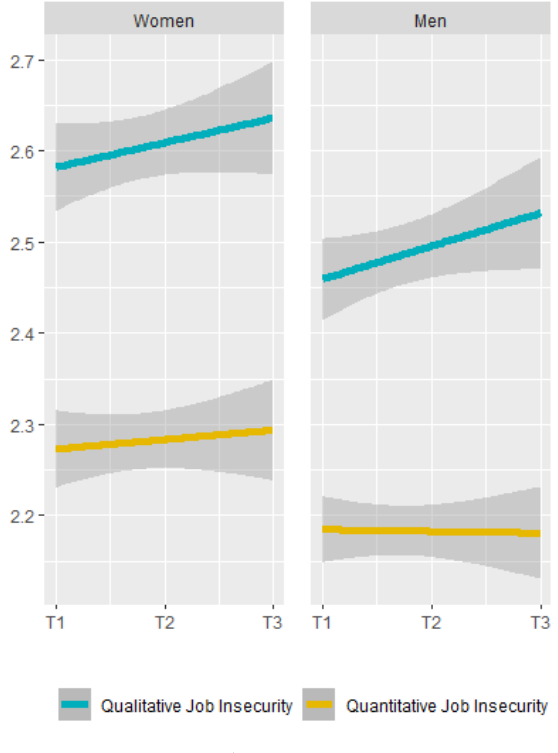
Figure A2. Figure gender.